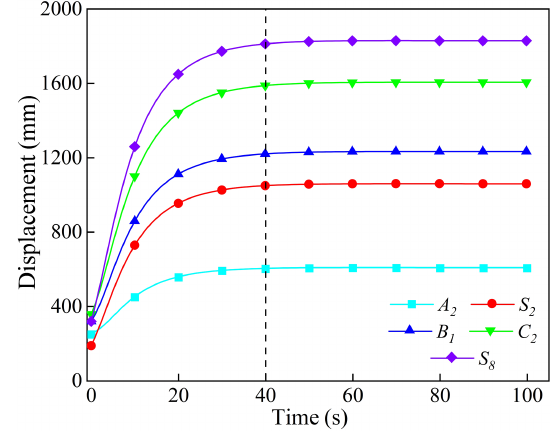
Figure 16. Displacement